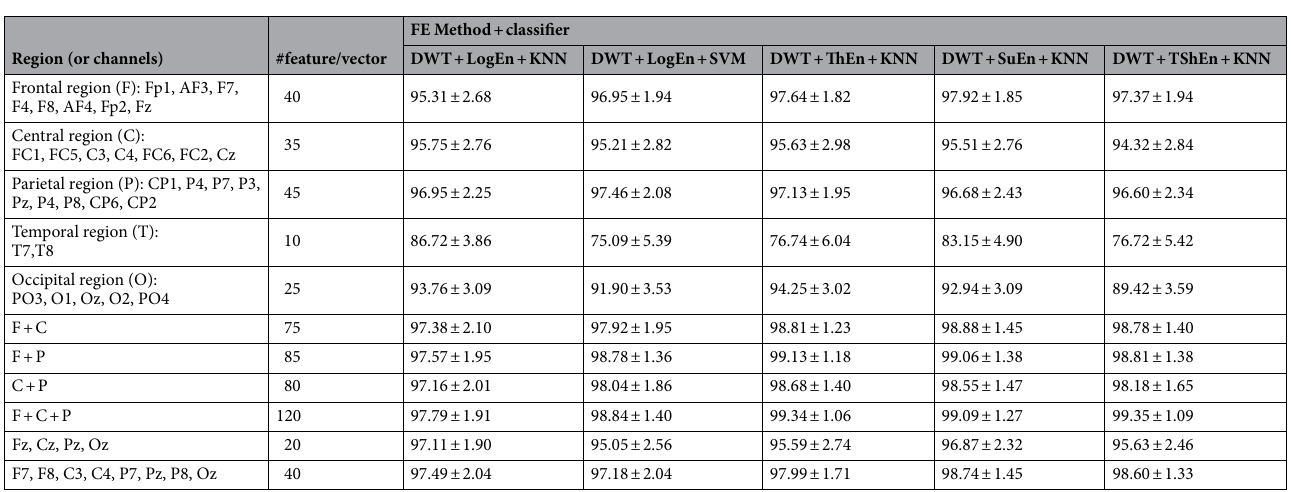
Table 6. Investigation of channels used on the classification performance (off-PD vs.